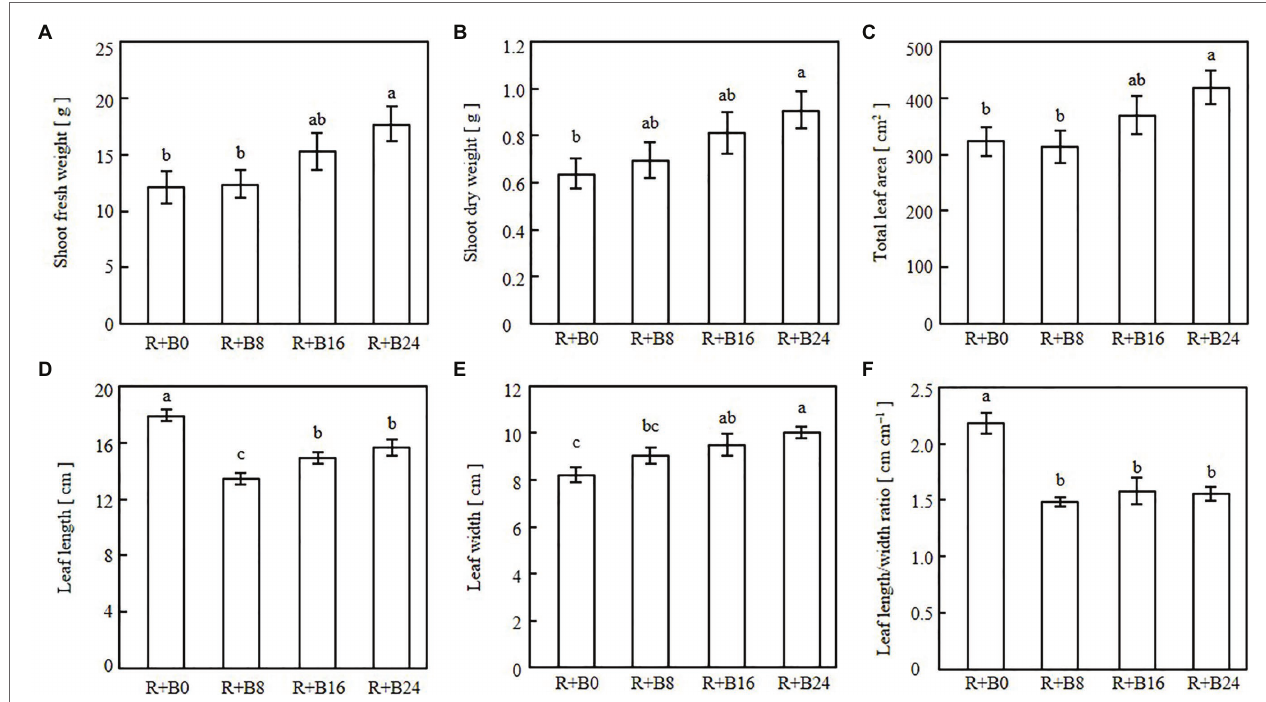
FIGURE 7 | Shoot fresh weights (A) , shoot dry weights (B) , total leaf areas (C) , leaf lengths (D) , leaf widths (E) , and leaf length/width ratios (F) of cos lettuce seedlings under irradiation conditions described in Figure 2 (Experiment 2). Bars represent SEMs ( n = 8). Different lower-case letters above bars within a panel indicate a significant difference ( p < 0.05, Tukey–Kramer HSD test).